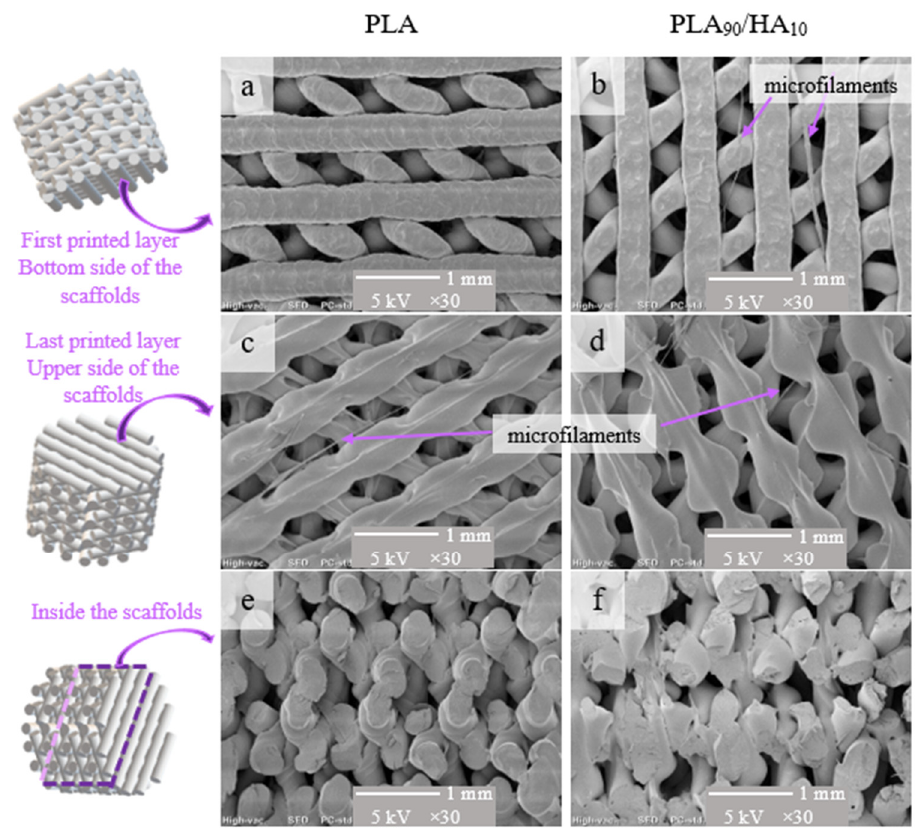
Figure 3. Schematic representation of the areas of the scaffolds (left) and SEM pictures (right) of the different zones of the scaffolds; ( a , c , e ): PLA scaffolds and ( b , d , f ): PLA 90 /HA 10 scaffolds. Their structure is the same in terms of lay-down pattern but depending on the orientation of the samples in the SEM sample holder, the orientation of the filament in the pictures may appear different. Incrementing the deposition angle by 60° with each layer resulted in complex shaped porosities. Between the first 2 deposited layers (Figure 3a,b), they almost look like dia- monds with sides measuring about 500 µm, while between the first 3 deposited layers, they look like triangles with sides measuring between 100–300 µm (Figure 4).